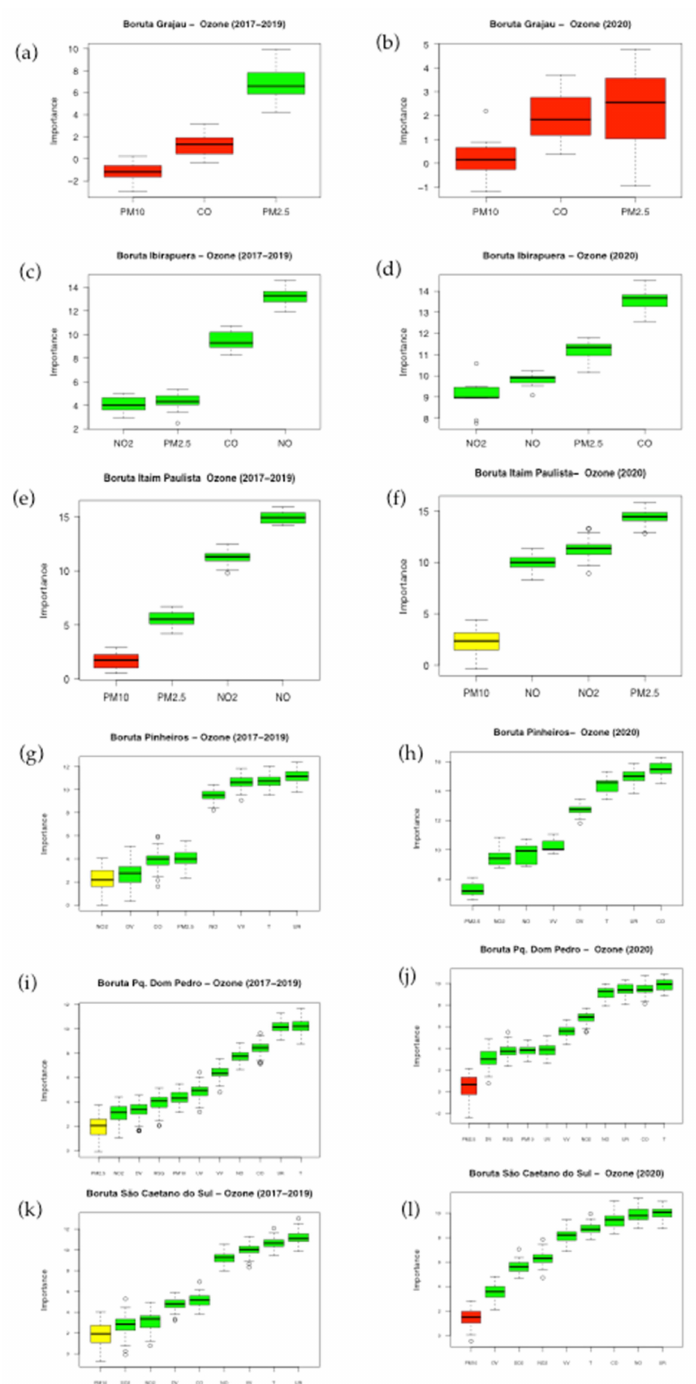
Figure 18. The Boruta calculation pollutants and meteorological variables that are most important for O 3 concentration (decrease or increase) in the MASP during the pandemic and pre-pandemic periods from ground